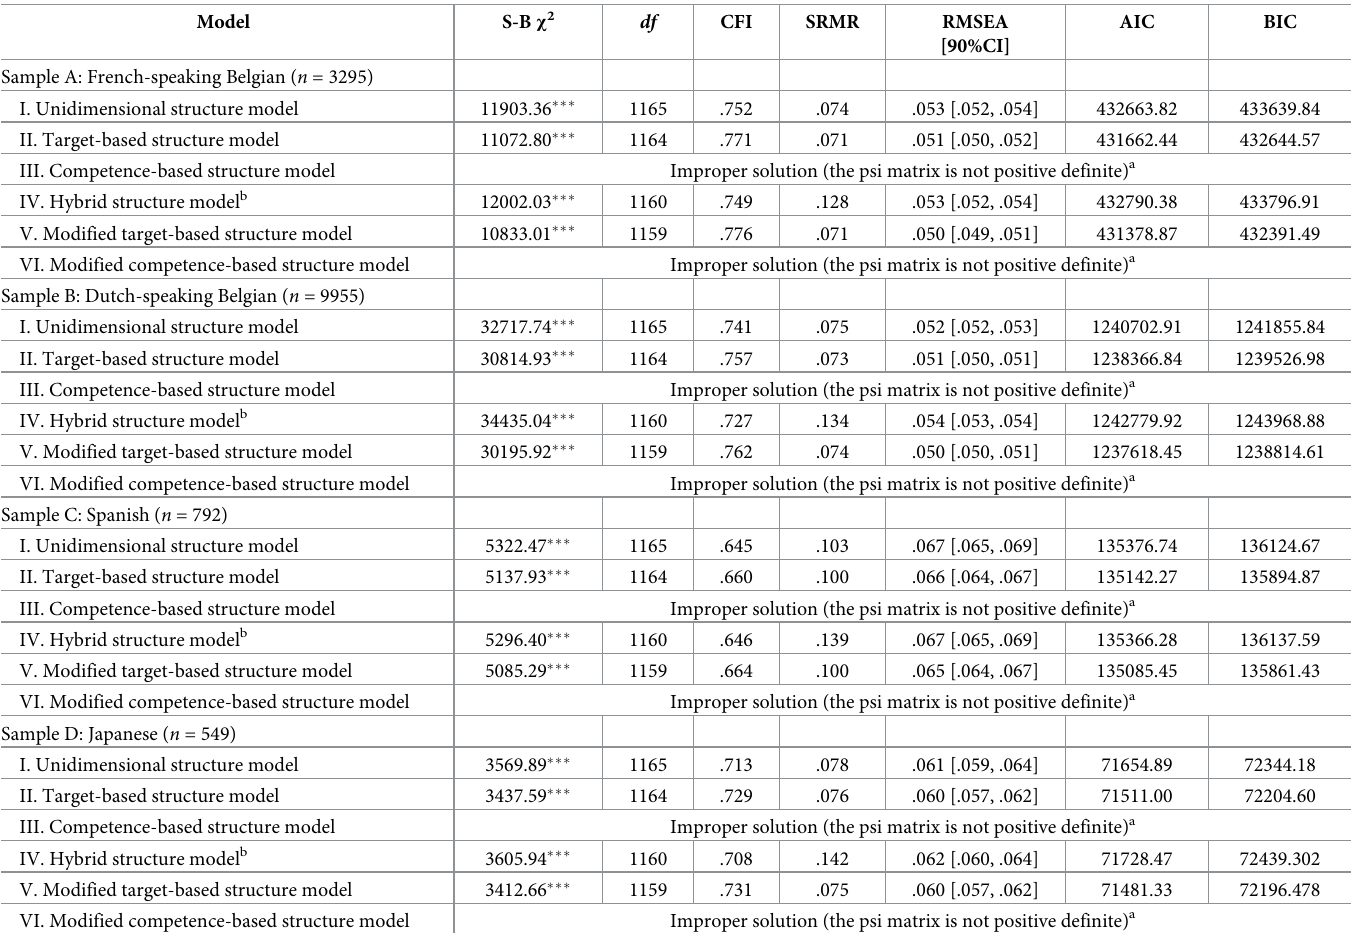
Table 1. Fit indices of CFA with a robust maximum likelihood